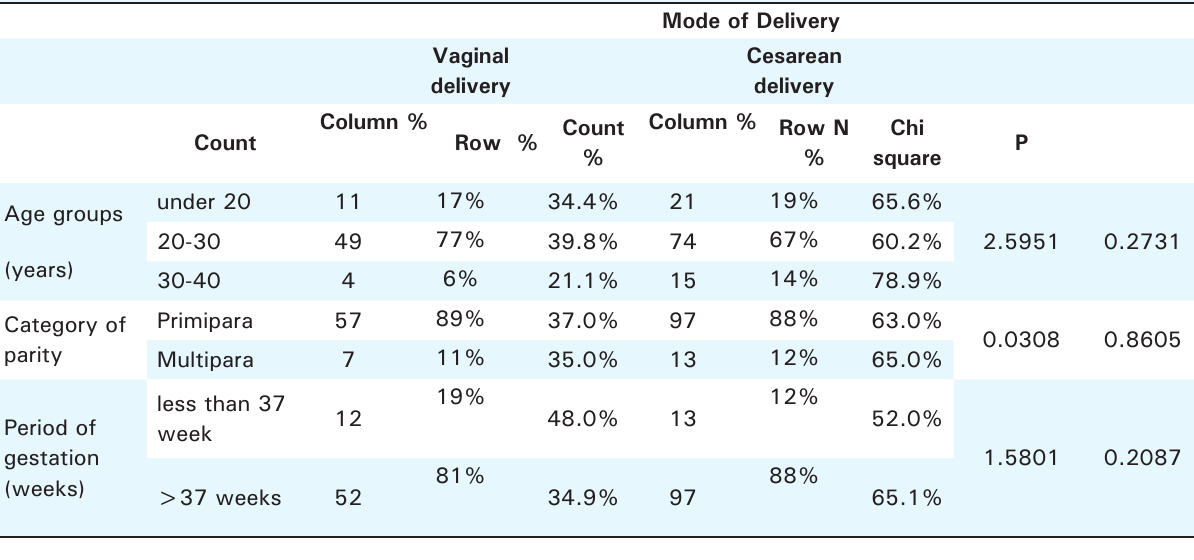
Table 1. Frequency table of age group, parity and period of gestation in different mode of delivery.